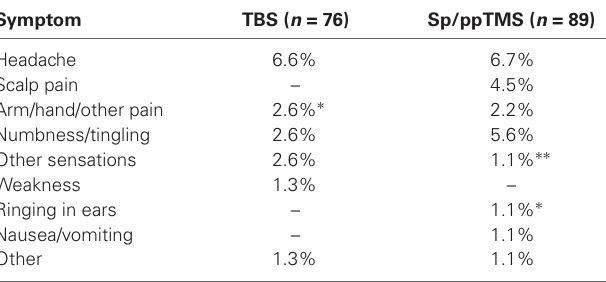
Table 2 | Percentages of participants experiencing specific adverse events